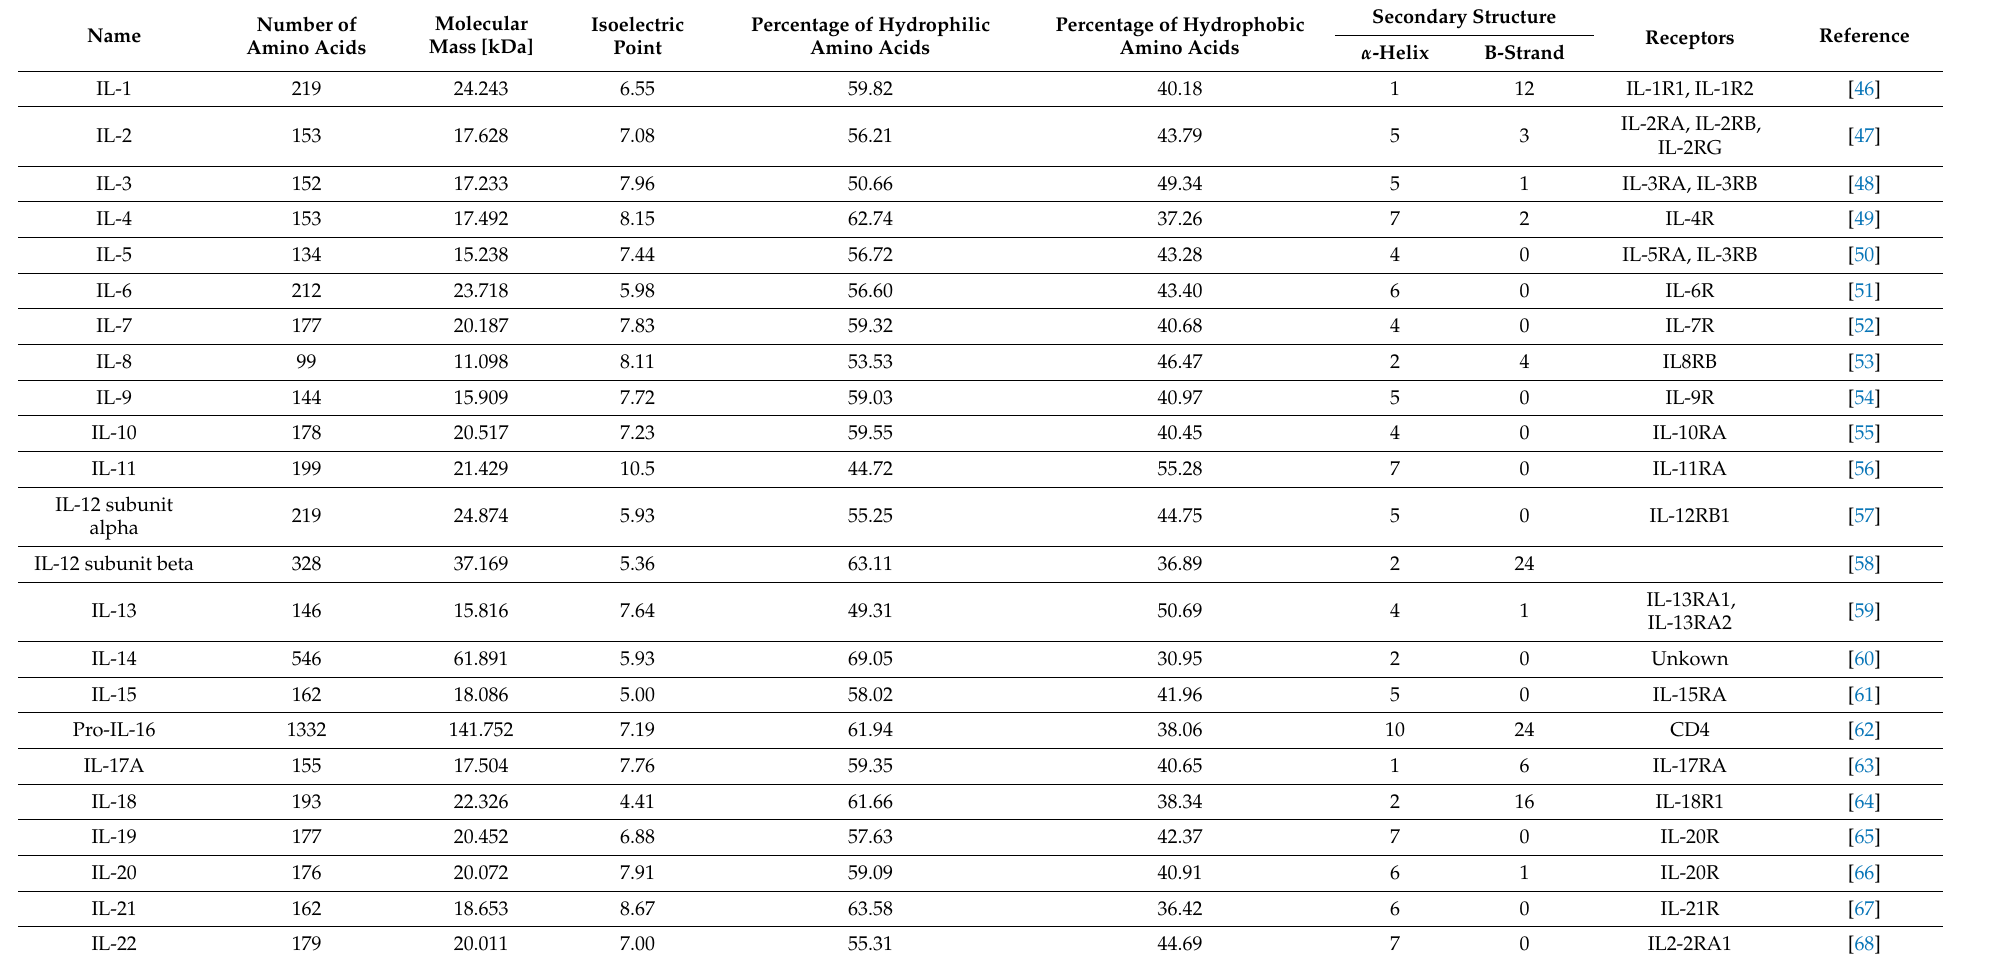
Table 1. Molecular characteristics of the